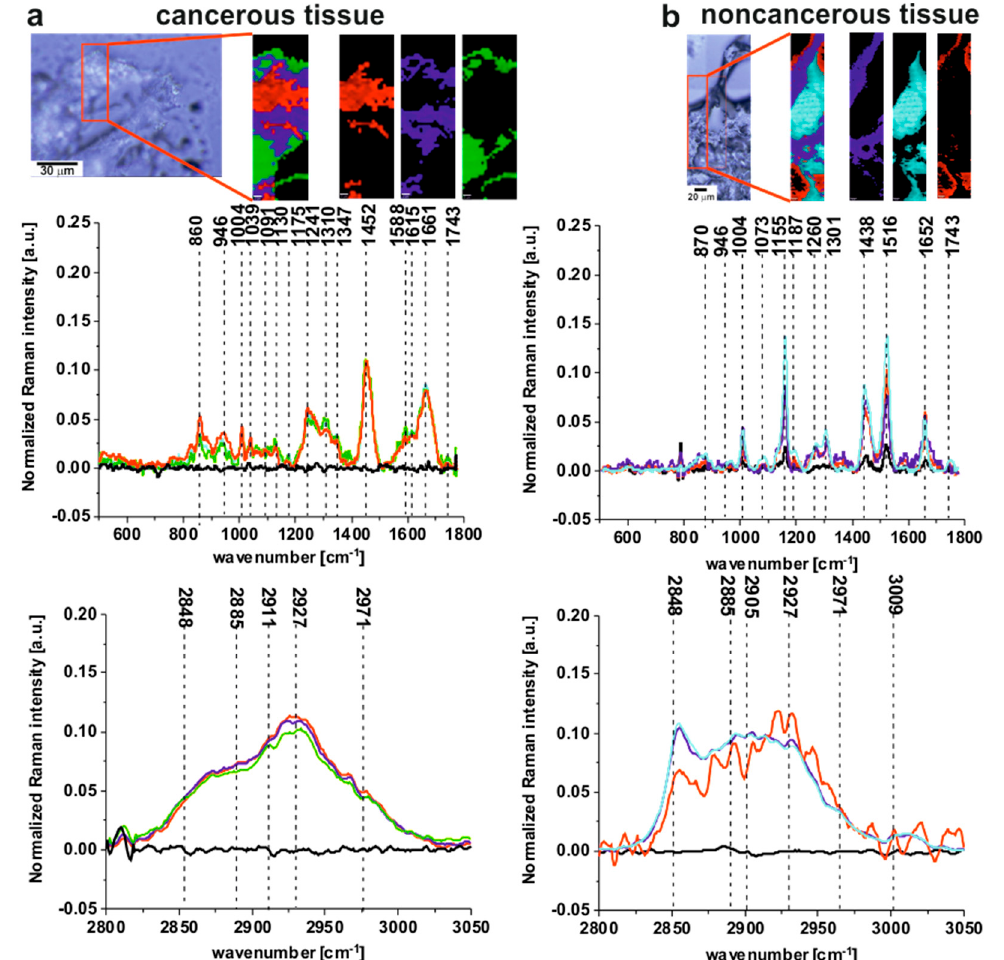
Figure 1. The microscopy image, the Raman image and Raman spectra obtained using Cluster Analysis method for fingerprint and high frequency regions (colors of the spectra correspond to the colors of Raman imaging) for cancerous ( a ) and noncancerous ( b ) tissues of human colon samples (tubular carcinoma, cancer stage G2) from patient P3. Raman image size: 20 × 60 µ m and 30 × 150 µ m for the cancerous and the noncancerous human colon tissues respectively.